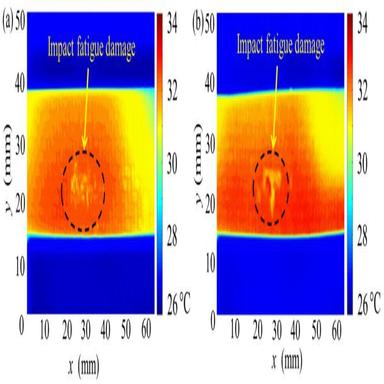
Thermal images of impact fatigue damages when the impact fatigue life is 0.8: (a) the impact energy of 3 J; (b) the impact energy of 7 J.